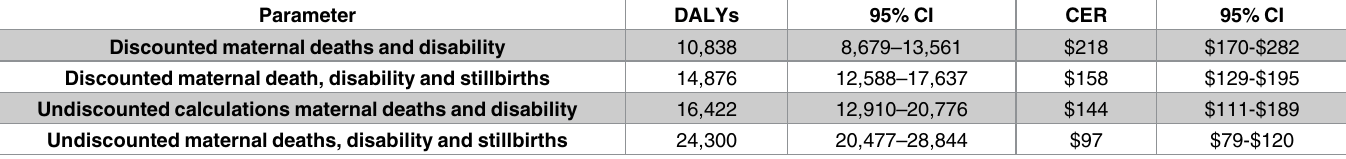
Table 4. Sensitivity analysis *